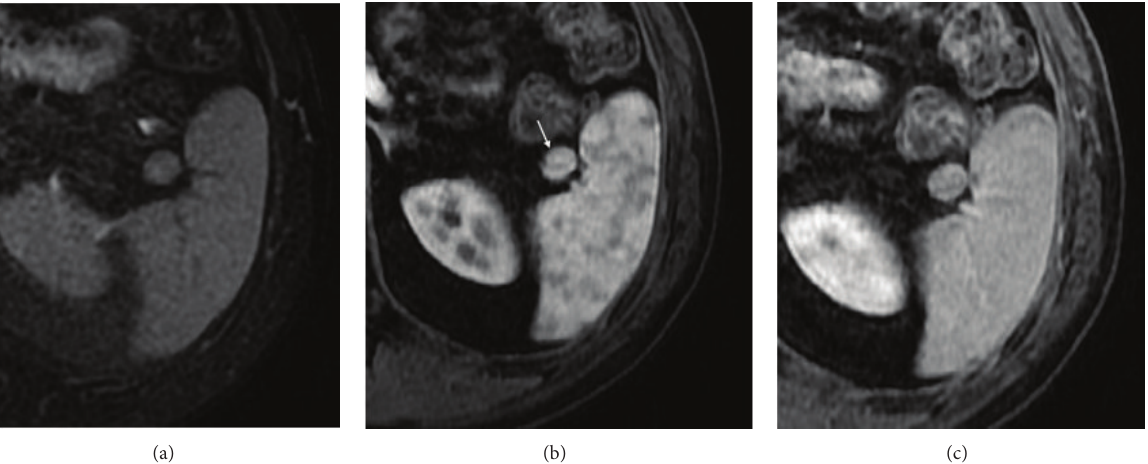
Figure 3: Accessory spleen. Axial T2wi FSE with fat suppression (a) and postcontrast axial 3D-GRE T1wi with fat suppression images at the arterial (b) and venous (c) phases. An accessory spleen is shown near the splenic hilum. Note the similar signal intensity and dynamic behavior comparable with the splenic